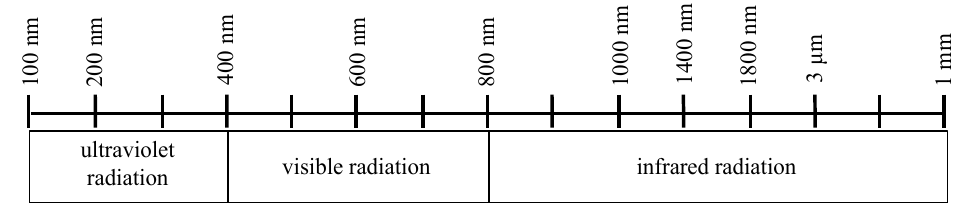
Figure 1. Wavelengths of different types of light. The hyperspectral camera processes visual light with a wavelength from 380 to 740 nm and light in the near infrared range from 750 to 1000 nm.